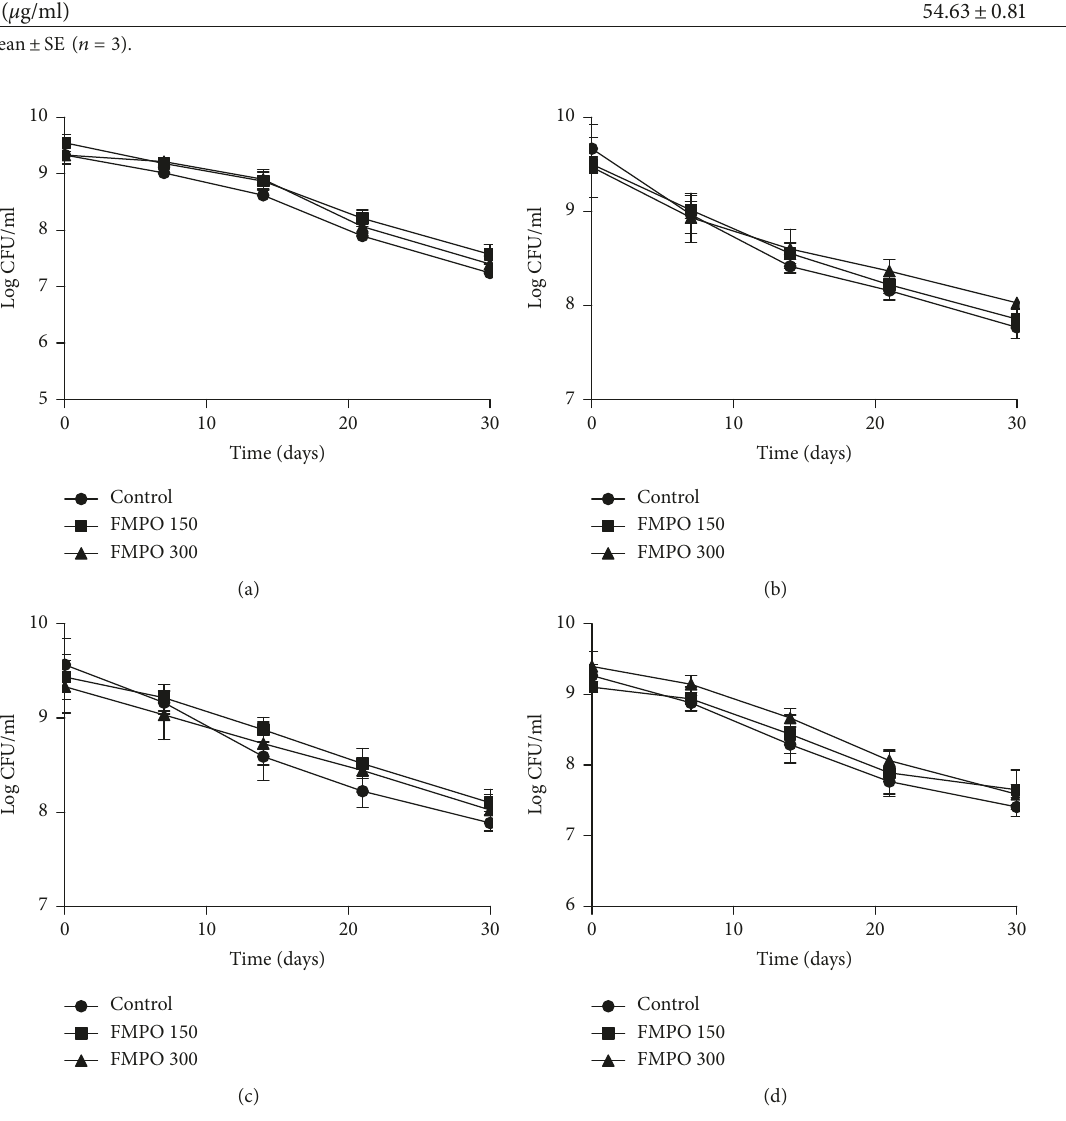
Figure 1: Cell numbers of Lactobacillus delbrueckii subsp. bulgaricus (a), Streptococcus thermophilus (b), Lactobacillus plantarum DMSZ 20079 (c), and Bifidobacterium longum subsp. longum DSMZ 200707 (d) during 30 days of storage at 4 ° C of FMPO 150 ( ■ ), FMPO 300 ( ▲ ), and FM ( ●